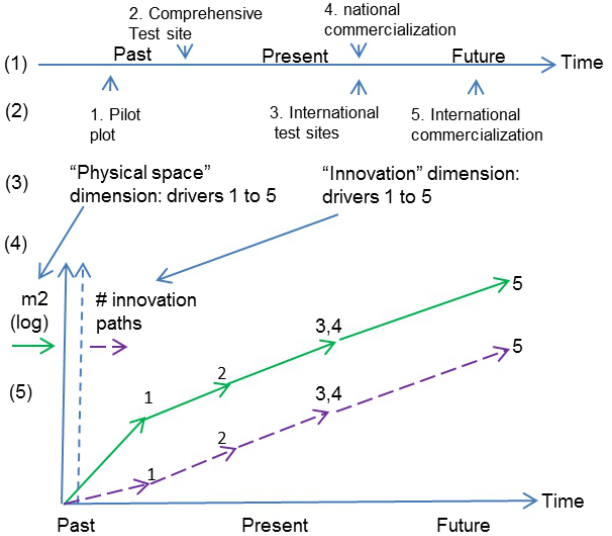
Fig. 2 . A simplified representation of the different steps in the scale